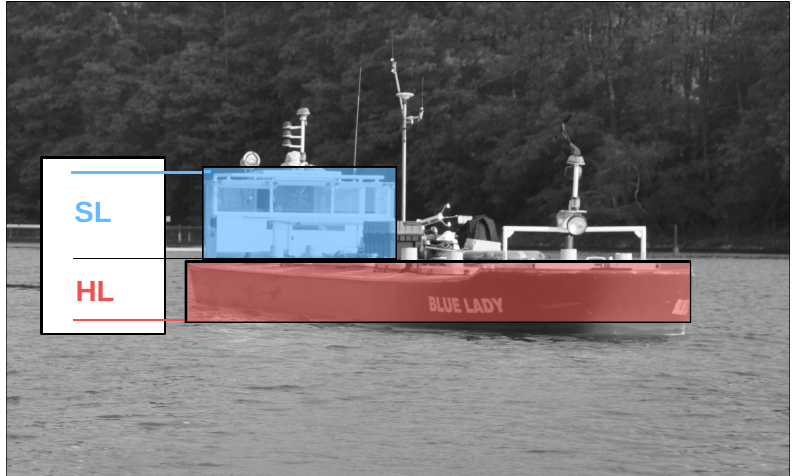
Figure 1. Ship silhouette with marked wind impact areas: HL—hull layer, SL—superstructure